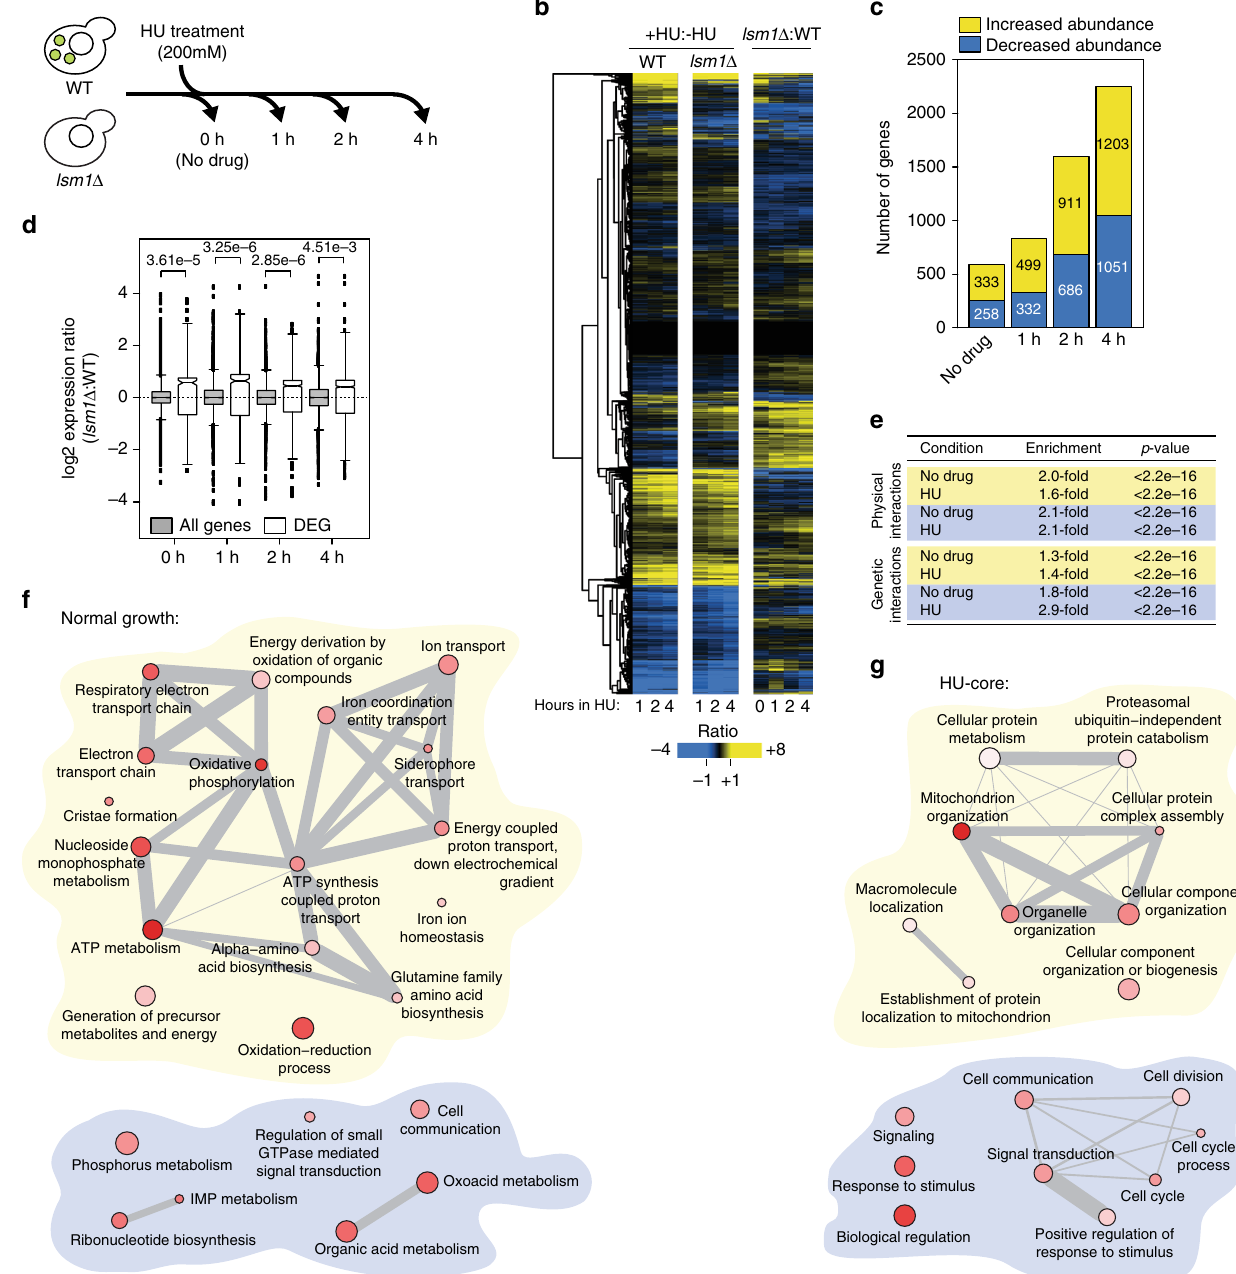
Fig. 1 The transcriptome is extensively remodeled when functional P-bodies are absent. a Overview of the RNA-seq strategy used to measure RNA abundance in lsm1 Δ cells. b Gene expression log2 ratios plotted as a heatmap. Expression ratios comparing HU treatment to the untreated condition (+HU: − HU), in wild type ( WT ) and lsm1 Δ , are plotted on the left . Expression ratios comparing lsm1 Δ cells to WT cells during normal growth and exposure to HU ( lsm1 Δ :WT) are plotted on the right . c The number of differentially expressed transcripts in lsm1 Δ during replication stress is plotted. d The distributions of the lsm1 Δ :WT expression ratios are displayed as boxplots for all genes ( gray ) and the differentially expressed genes ( white ). P -values are from unpaired Wilcoxon tests. e Summary of interaction enrichments for mRNAs with increased abundance in lsm1 Δ ( yellow ) and with decreased abundance in lsm1 Δ ( blue ) during normal growth (no drug) and during replication stress (HU). P -values were calculated using a binomial test. f GO term enrichment networks for mRNAs that were differentially expressed in lsm1 Δ during normal growth, for mRNAs with increased abundance ( yellow ) and mRNAs with decreased abundance ( blue ). Nodes are shaded according to P -values ( darkest red indicating the smallest P -value). Node size indicates the frequency at which a given GO term is found in the S. cerevisiae genome. Edges connect highly similar GO terms and edge thickness represents degree of similarity. g GO term enrichment networks for mRNAs that were differentially expressed in lsm1 Δ during HU treatment (HU-core